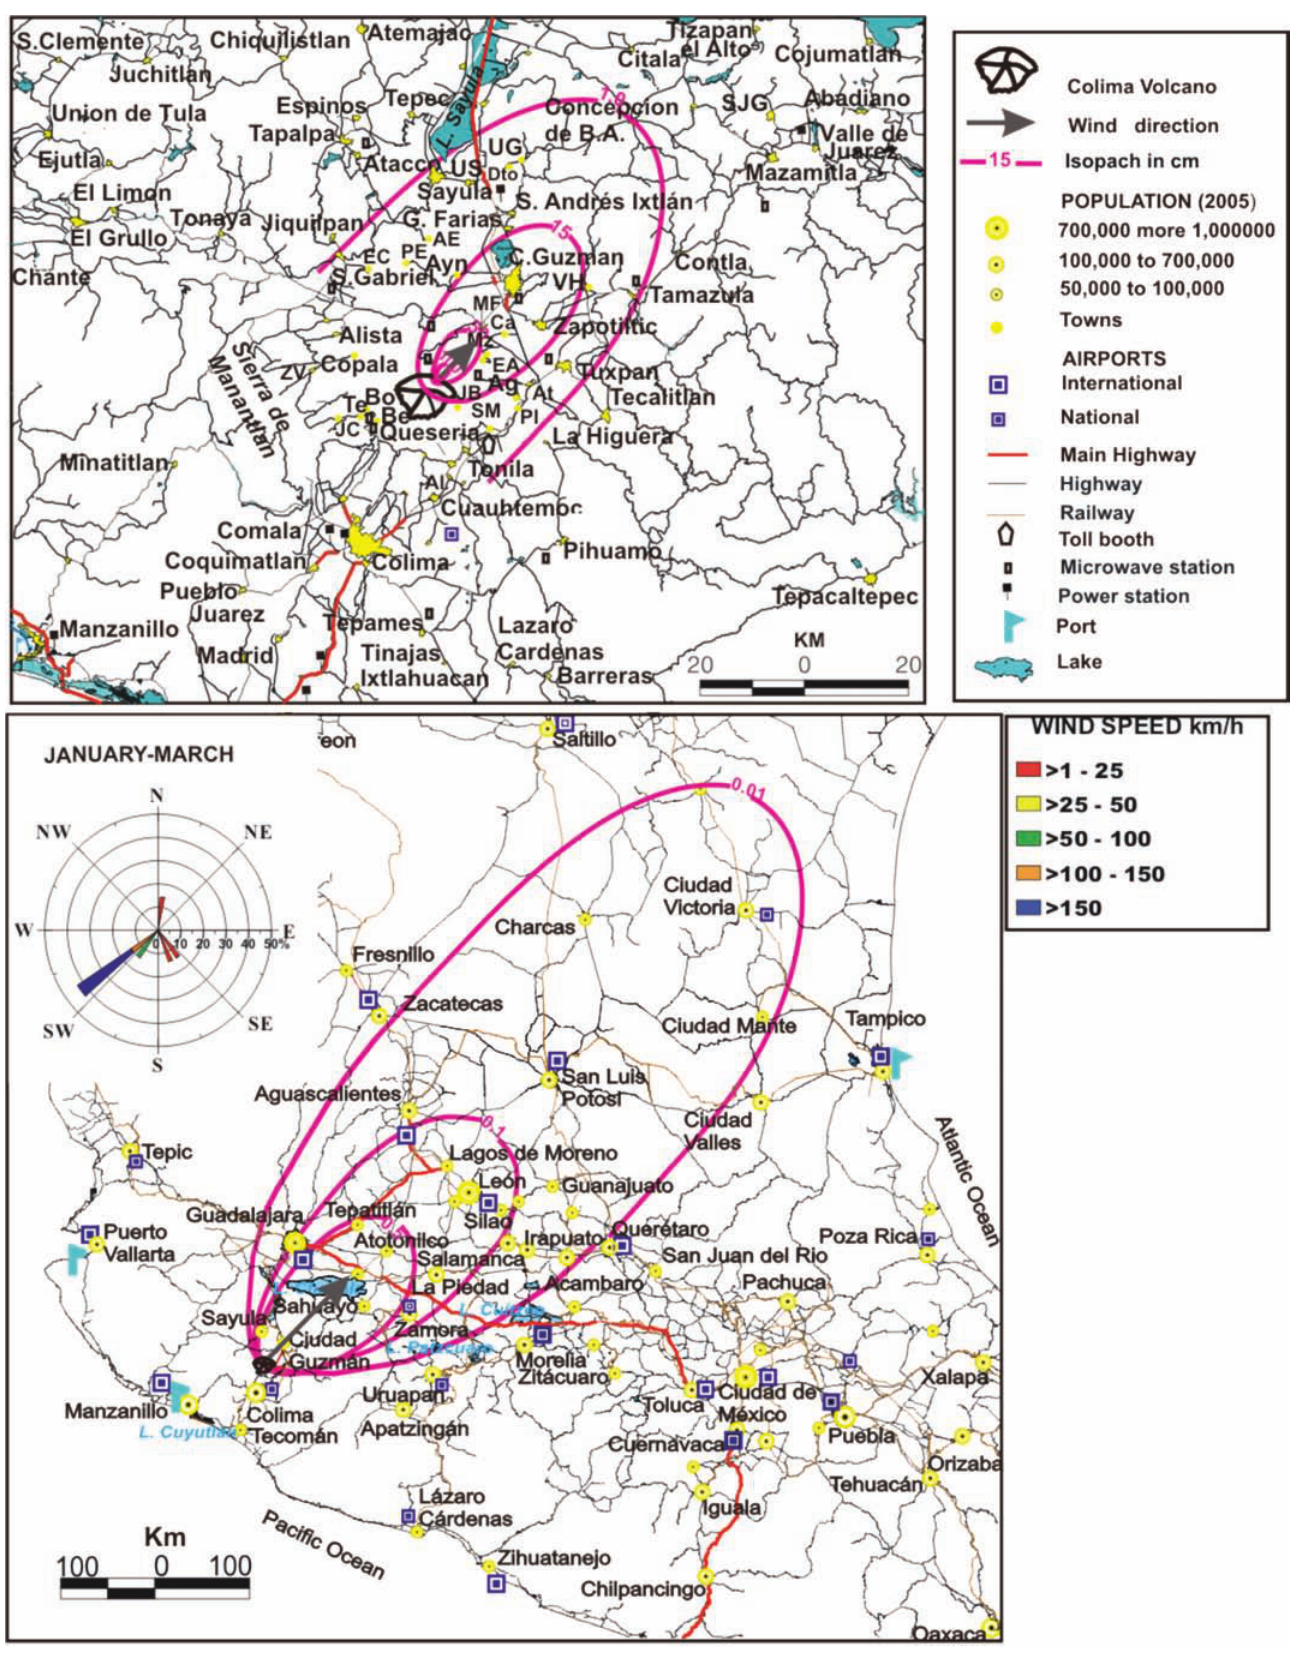
Figure 4. Scenario 1. For an eruption from January to March, showing the northeast area that would be affected by a future Plinian eruption. Two scales shown according to isopach contours: top, >1 cm; bottom, 0.01 cm to 0.5 cm. The maps show the main cities, populations and airports. Towns: (Pl) El Platanar; (Bo) El Borbollon; (Be) La Becerrera; (JB) Juan Barragan; (Ag) El Agosto; (Ma) San Marcos; (Te) El Tecuan; (At) Atenquique; (EA) Ejido Atenquique; (Mz) Los Mazos; (Ca) Las Canoas; (MF) La Mesa y el Fresnito; (Al) Alcaraces; (ZV) Zapotitlán de Vadillo; (Dto) El Destacamento; (PE) Los Pozos y el Ocote; (VH) Vista Hermosa; (SJG) San José de Gracia; (LB) Loma Blanca; (AE) Agua Escondida; (EC) El Carpintero; (Ayn) Atequizayán; (US) Usmajac. Inset: wind diagram showing frequency in percentage and wind speed in